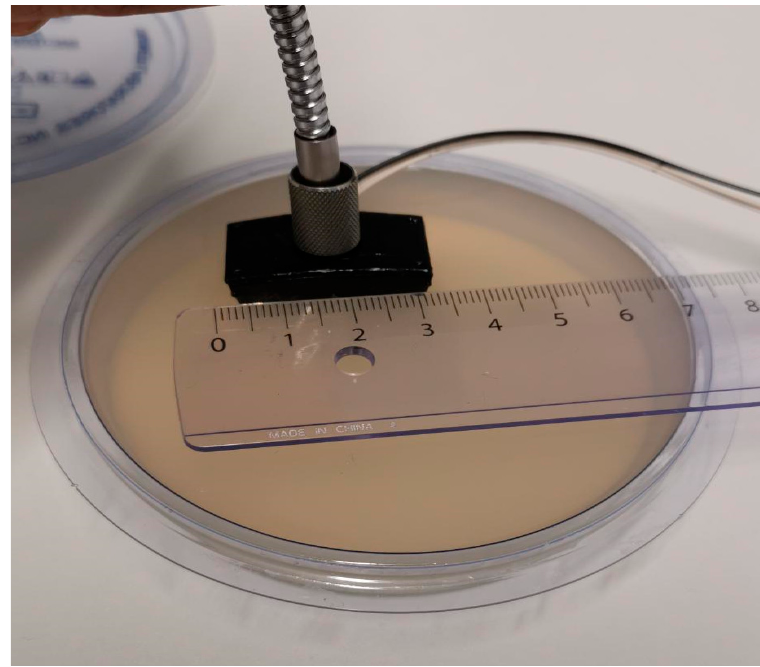
Figure 1. The probe and its optical connection during the in vivo experiment.